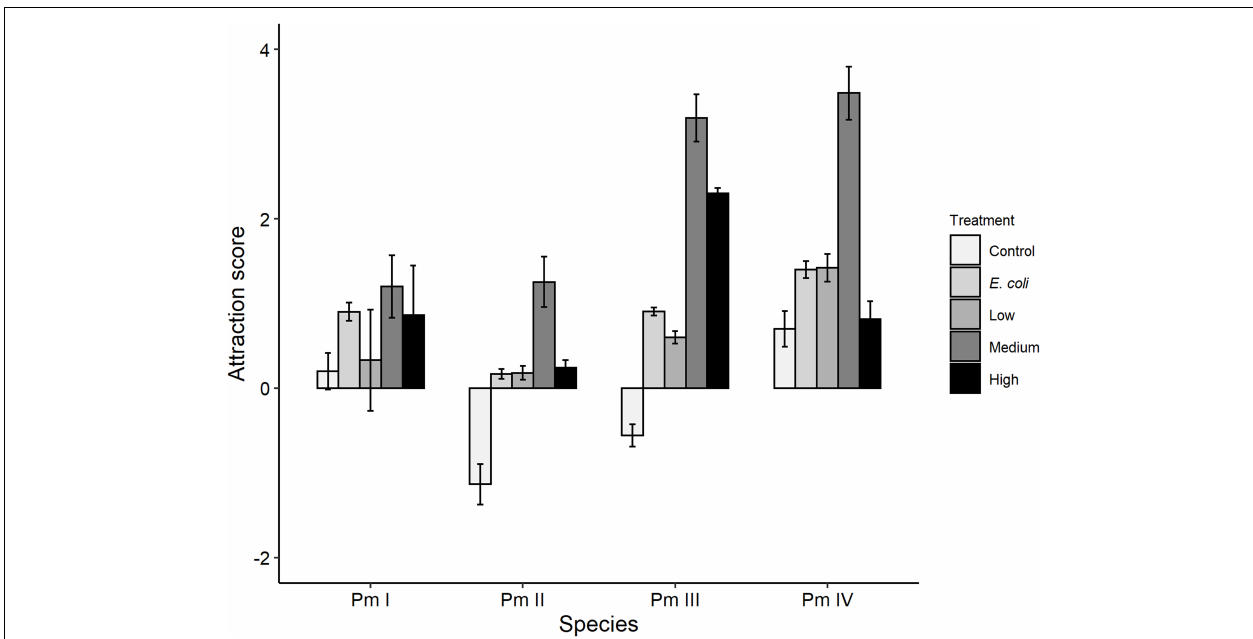
FIGURE 3 | Taxis-to-food scores (mean ± SE) for the four cryptic species of L. marina (Pm I, Pm II, Pm III, and Pm IV) in the control (no food) and different food treatments ( E. coli , low diversity, medium diversity, high diversity) ( n = 4).